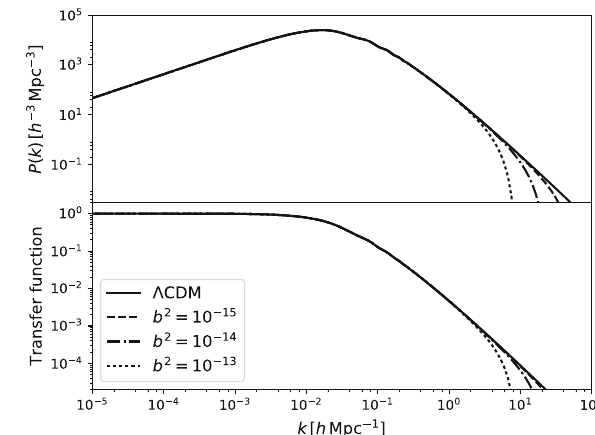
power spectrum and bottom right panel: transfer function for different b -values. Note that suppression in small scales is proportional to b and is more evident in these quantities